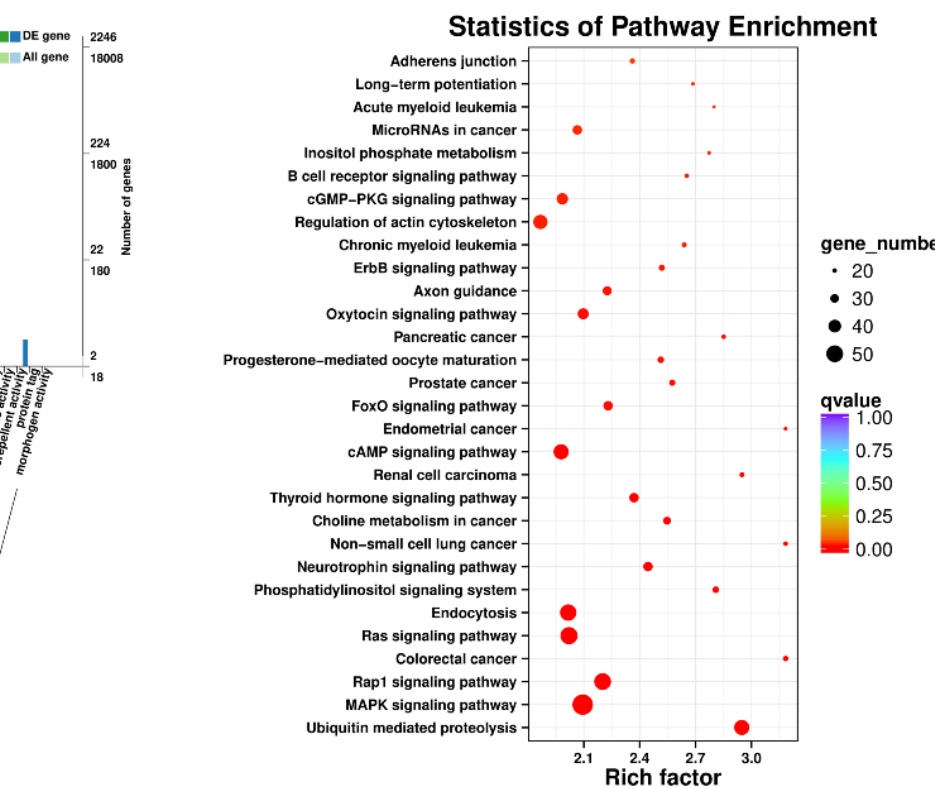
Figure 3. Functions analysis of circRNA. ( A ) Gene Ontology (GO) analysis of host genes. ( B ) KEGG enrichment analysis shows top 30 significantly enriched KEGG pathways for circRNA host genes.